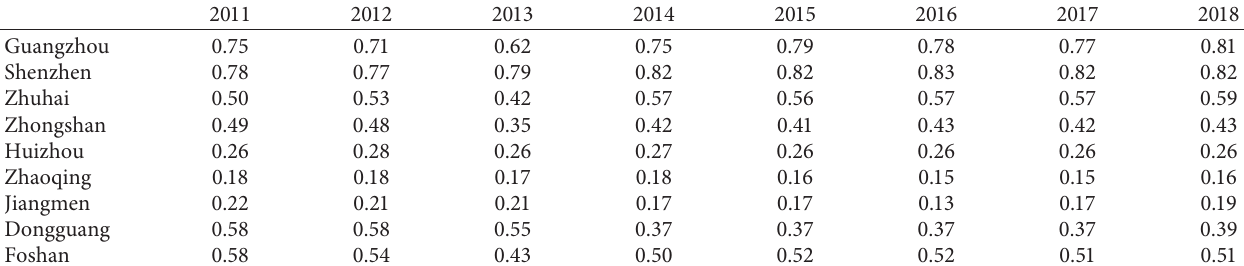
Table 18: Comprehensive well-being evaluation index of cities 2011–2018.